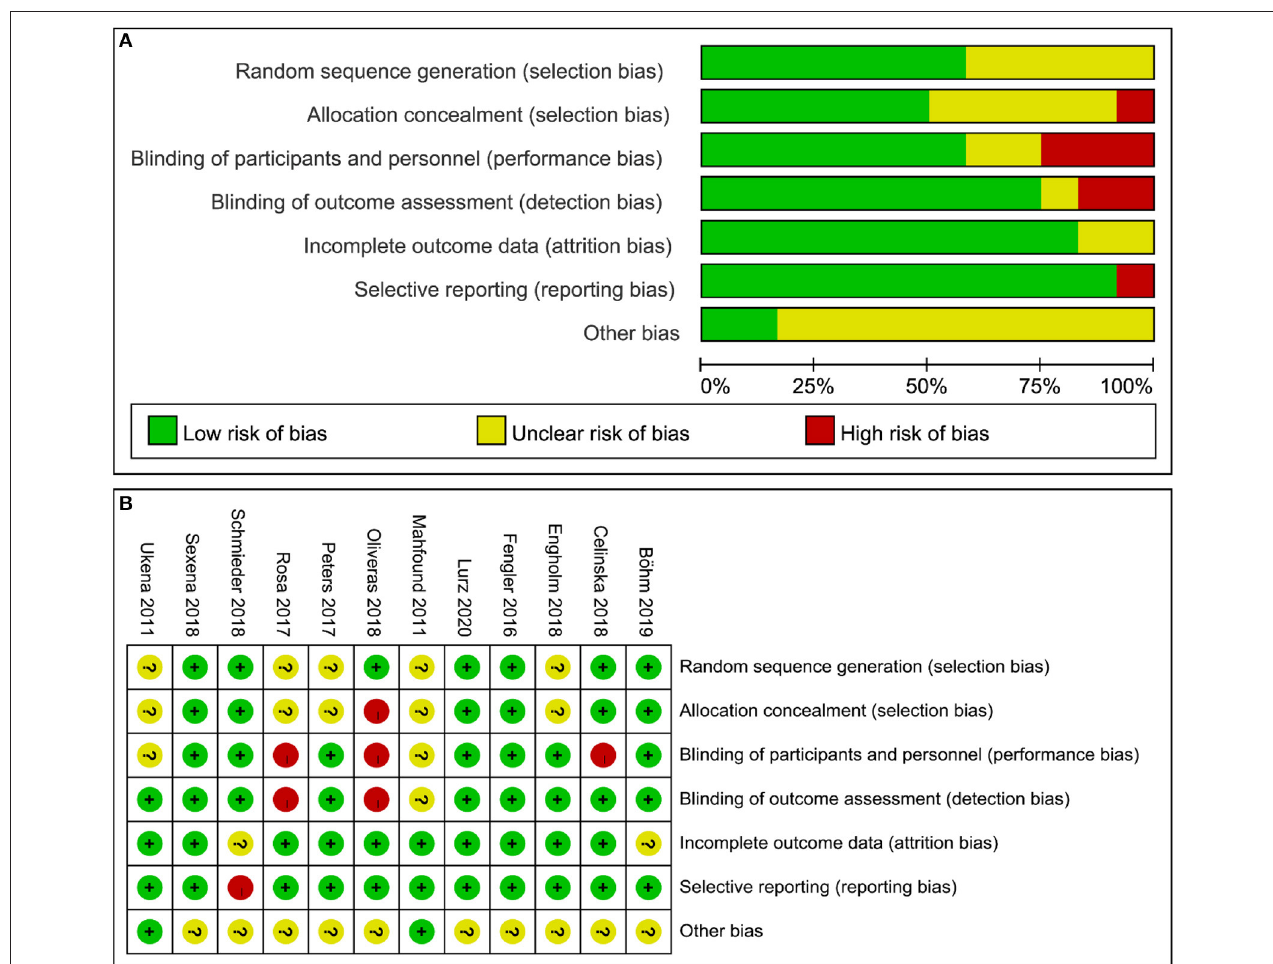
FIGURE 2 | Quality evaluation of the included studies. (A) Review authors’ judgments presented as percentages for the included studies; (B) Review authors’ judgements for each included study.